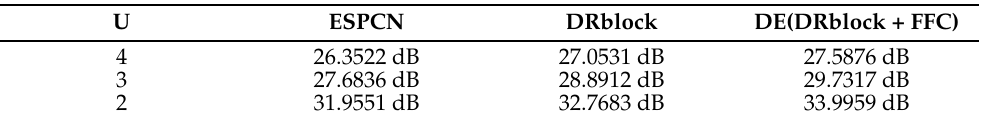
Table 2. Comparison experiment of the proposed DE module, when different settings were adopted, using the Satellite dataset II (East